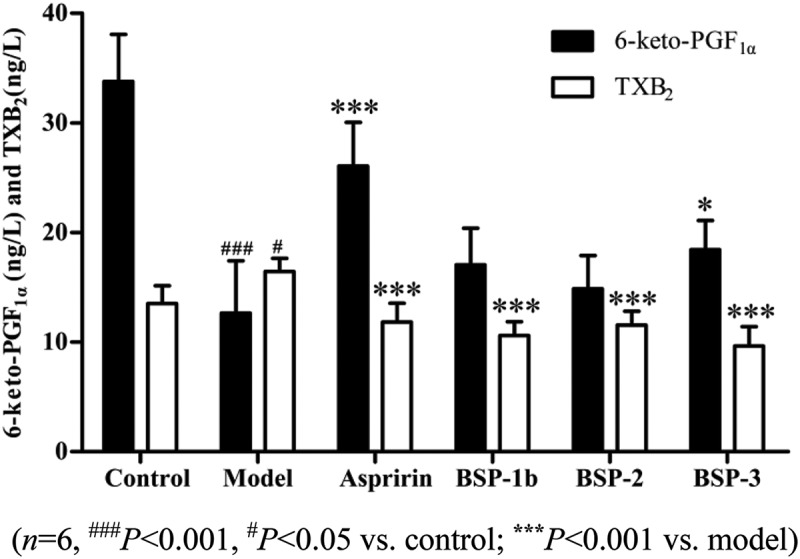
Effect on 6-keto-PGE1α and TXB2 in rats.(n = 6, ###
P < 0.001, #
P < 0.05 vs. control; ***
P < 0.001 vs. model).